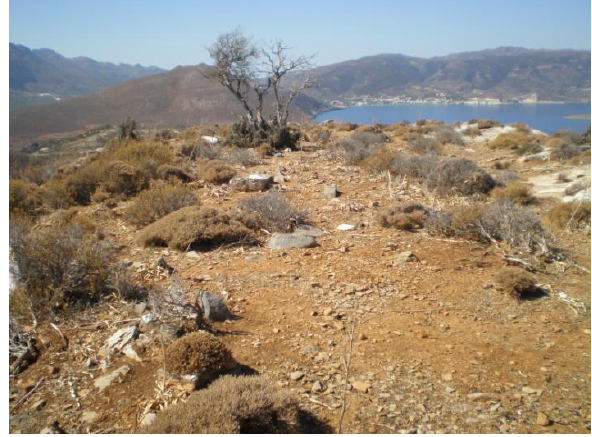
Figure 3. Agios Antonios Chomatas Site 9: the actual state of the site